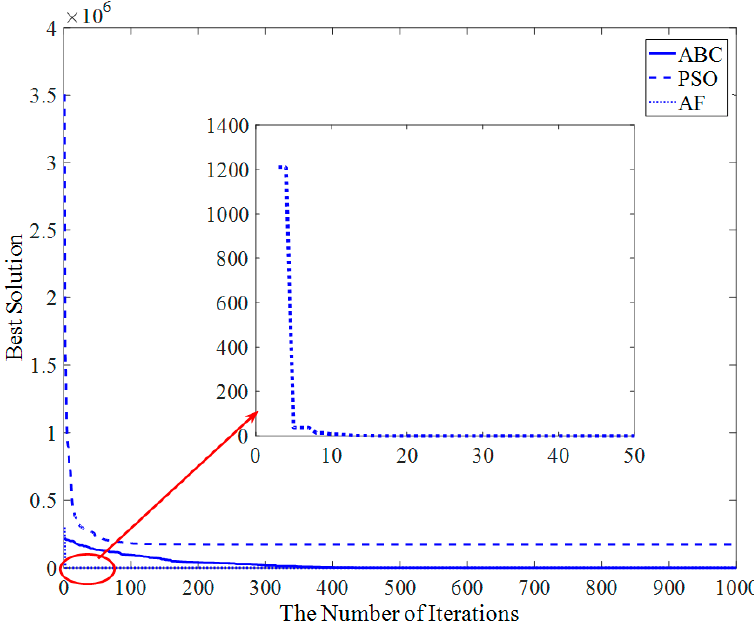
Figure 15. The convergence curve of the three algorithms for Sphere function in 100-dimensional space.